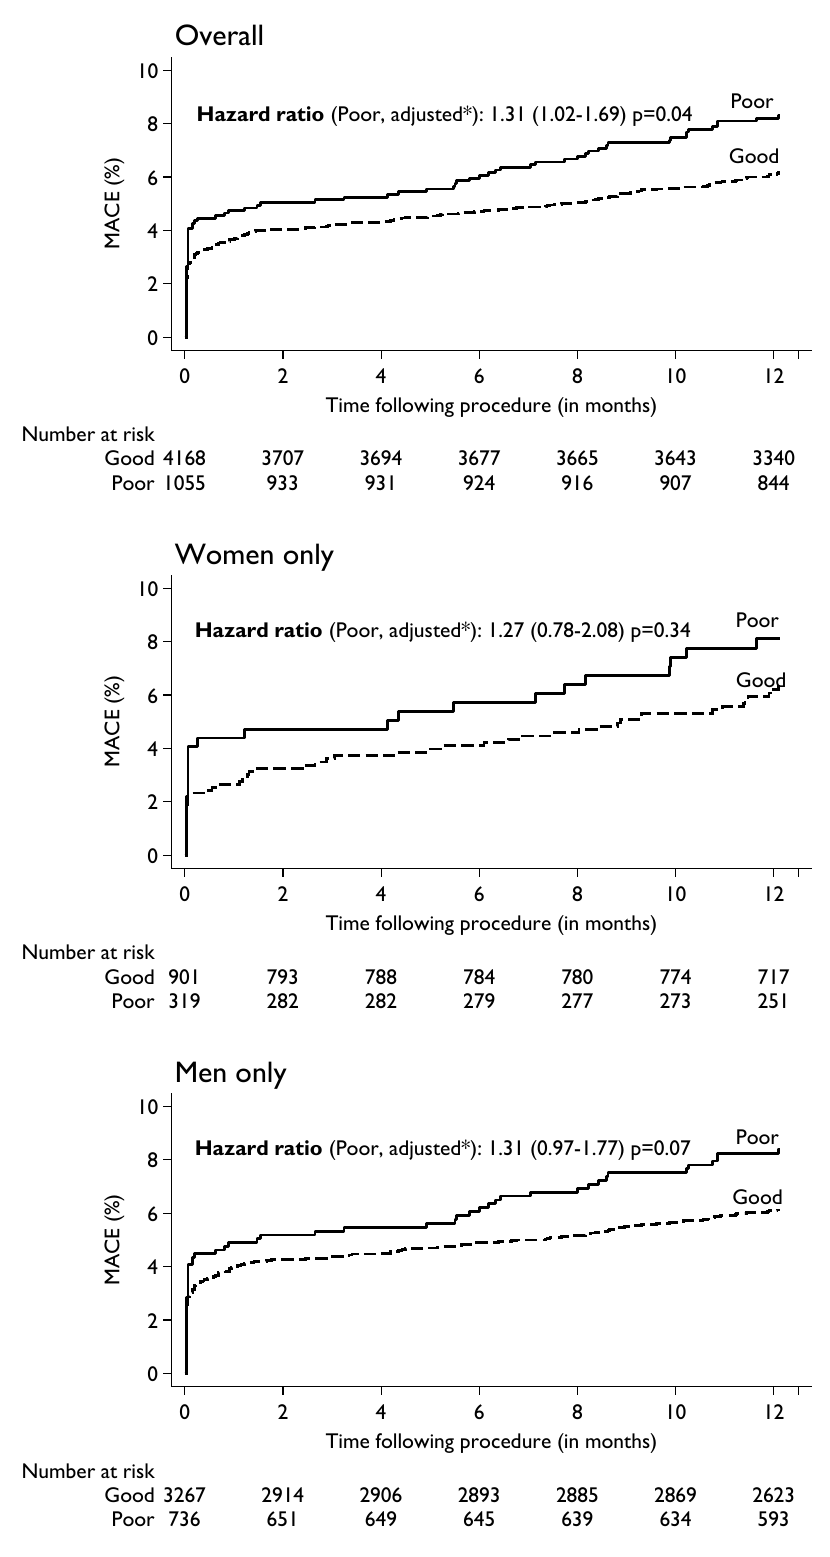
Figure 2. Pre-procedure HRQoL (N = 5223) and its association with MACE within one-year following procedure in the Overall (top), women only (middle) and men only (bottom panel). MACE = major adverse cardiovascular events. * Adjusted for age, sex (except for gender specific analysis), BMI, smoking, PCI presentation, diabetes, LVEF, previous MI, PVD, previous CABG, HF within prior 2 weeks of PCI, renal failure and cardiogenic shock.